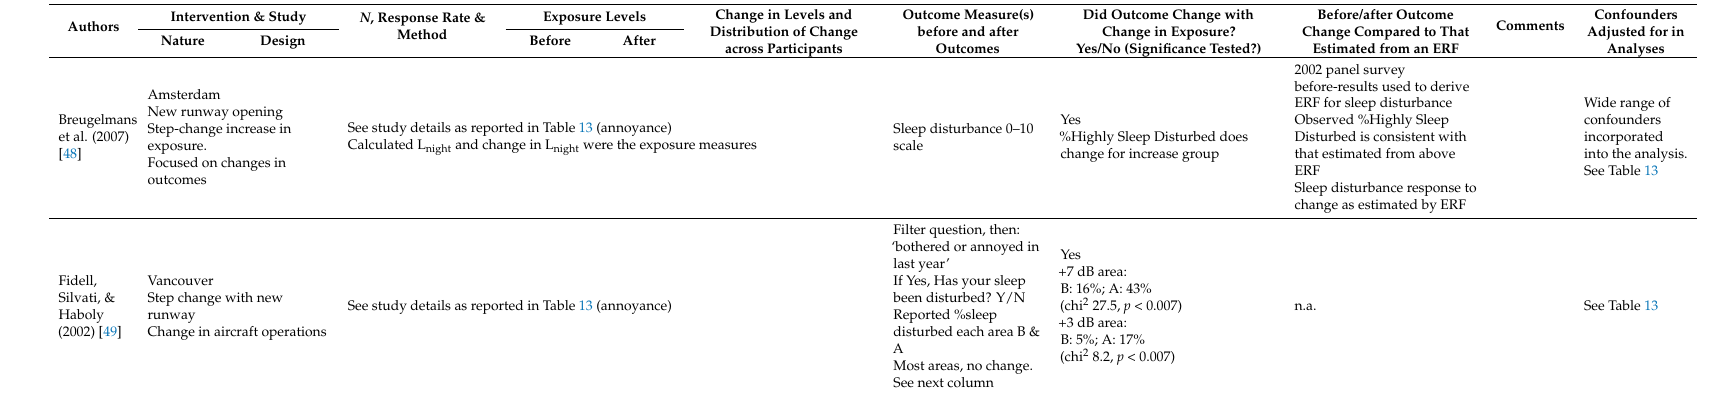
Table 14. New/Closed Infrastructure (Type C).